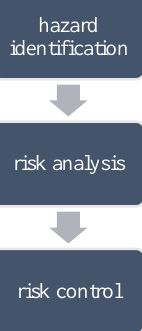
Figure 4. Risk Assessment Steps